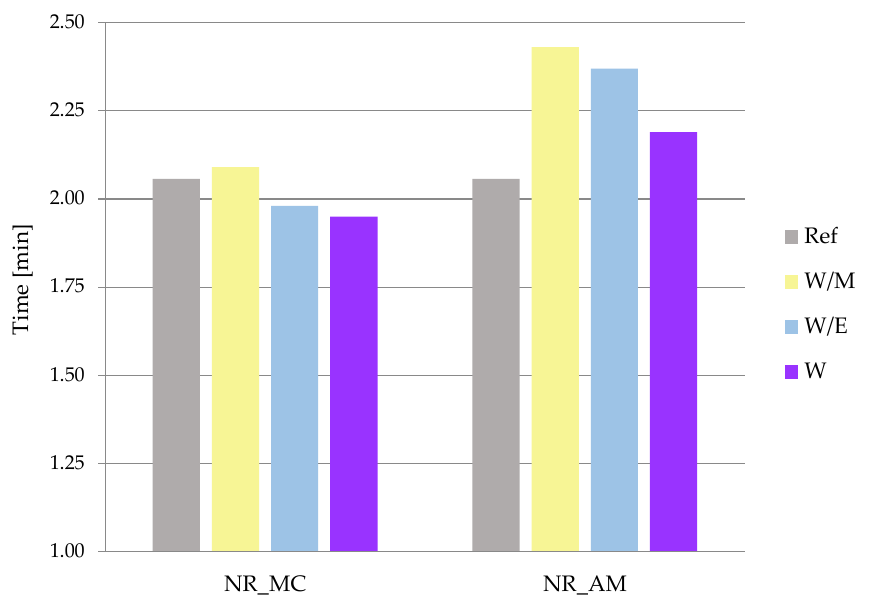
Figure 7. Optimal vulcanization time (t 90 ) of vulcanizates.